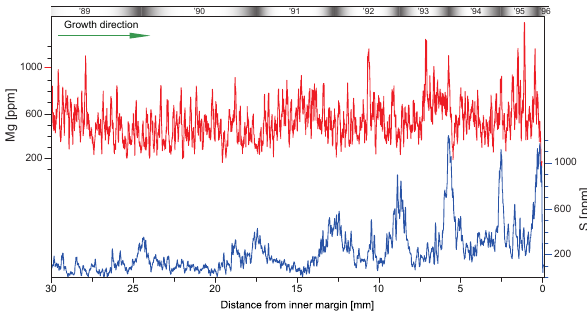
Figure 4. Changes in the moving average trends (15-point smooth- ing window) of magnesium and total sulfur in the inner shell layer of H. hippopus , obtained by the µ -XRF/XAS method at 8µm inter- vals. The spatial resolution of µ -XRF allows the variations of the Mg and S content to be examined at a daily timescale (300–850 points per